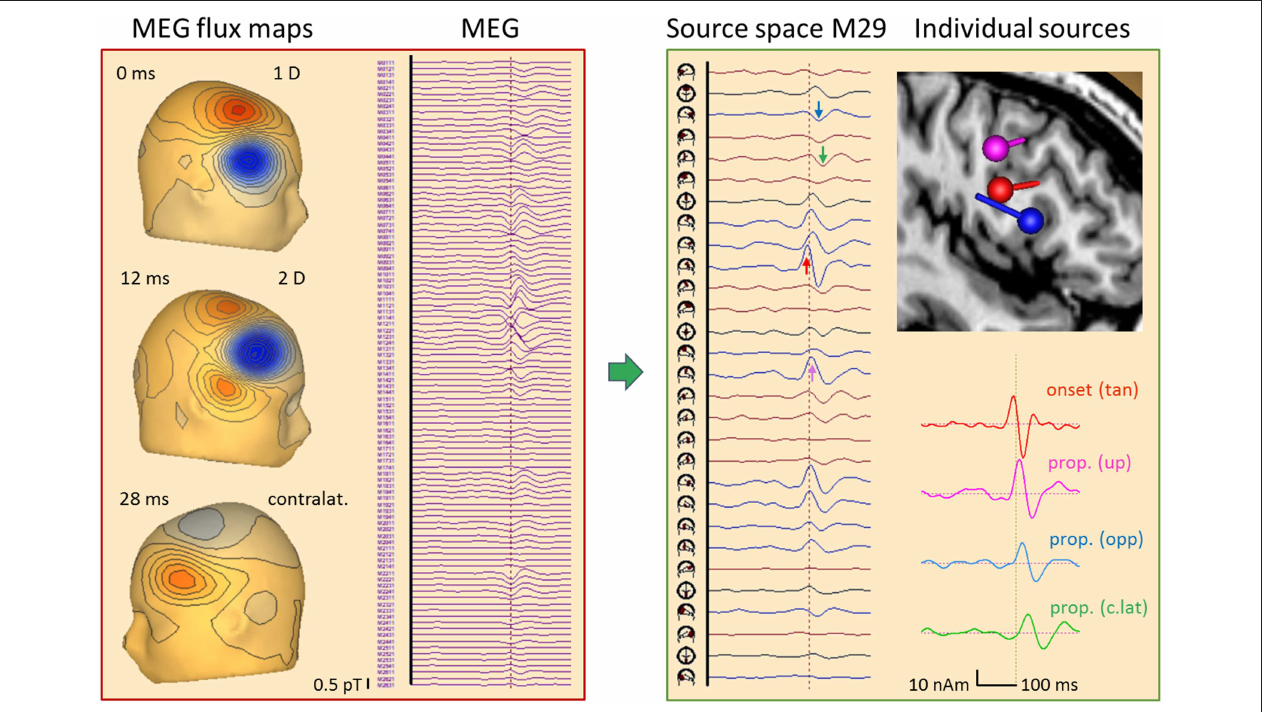
FIGURE 13 | Right frontal propagating IED, 84 averages, MEG results. Time epoch and filtering same as in Figure 12 . The 102 magnetometer signals (left) are transformed into source space M29 ( 16). Each source has 2 tangential dipoles and is rotated to show the maximum tangential activity in each of the 29 regions. The onset shows the largest peak at the right frontal source (red arrow) followed by a delayed peak below C4 (pink) and later peaks below F8 (blue) and F3 (green). A multiple discrete source model with 4 dipoles was sufficient (see text) to separate the onset (red) from activities propagated upwards (pink), forward to the other side of the gyrus (blue) and to contralateral (green), as seen clearly by the increasing delay of the typical biphasic spike pattern in the 4 source waveforms. The flux map at 12ms illustrates that localization by a single dipole is no longer possible when the propagated activities start overlapping in a complex